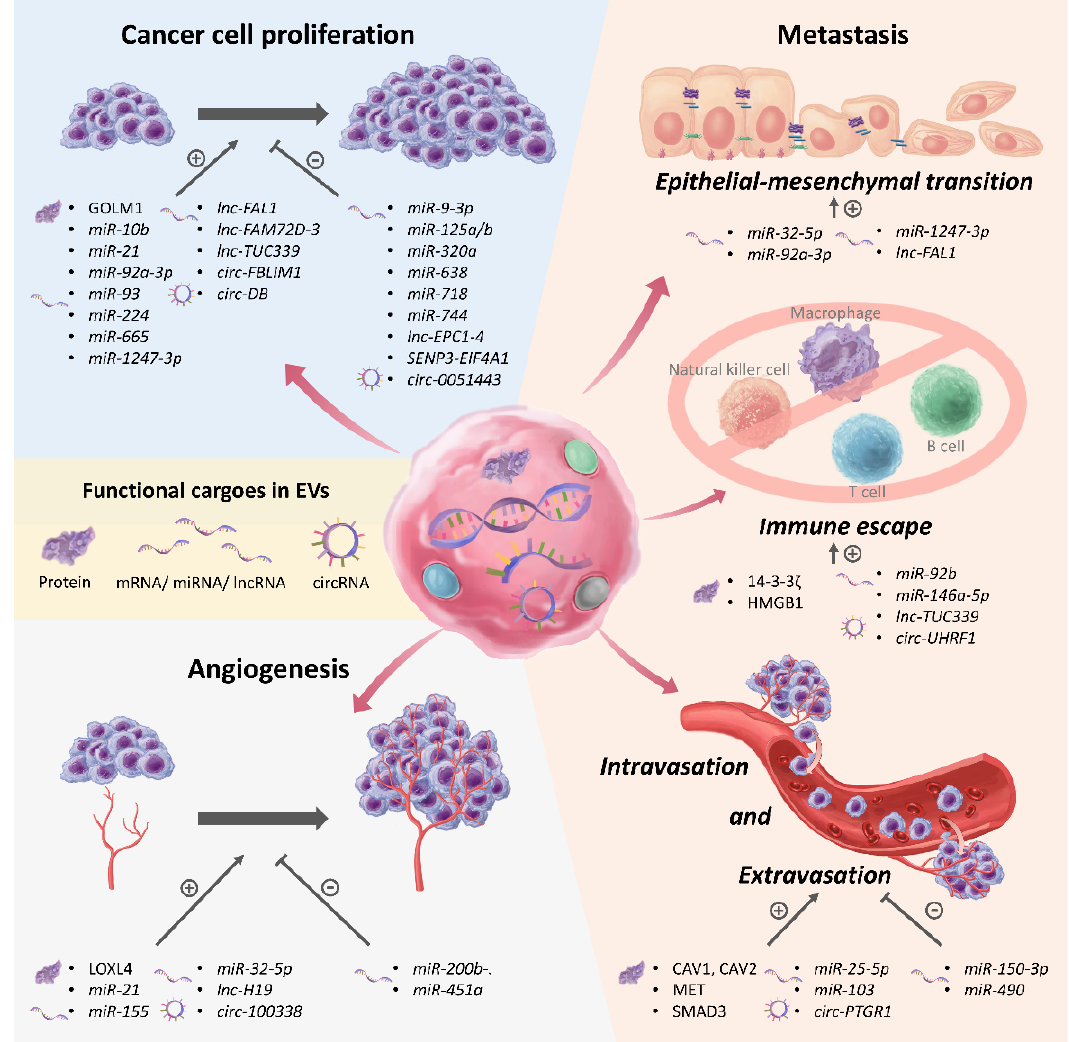
Figure 2. EVs as mediators in progression of HCC. Studies have demonstrated that EVs regulate cancer cell proliferation, angiogenesis, epithelial–mesenchymal transition, immune escape, and intravasation and extravasation by their functional cargoes including proteins, miRNA, lncRNA, and circRNA.